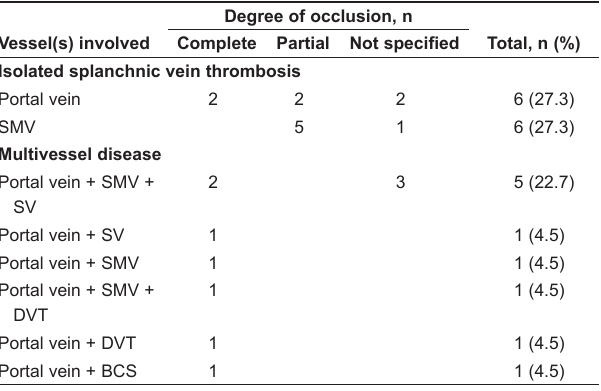
TABle 2 Risk factors for splanchnic vein thrombosis (n=22) Factor